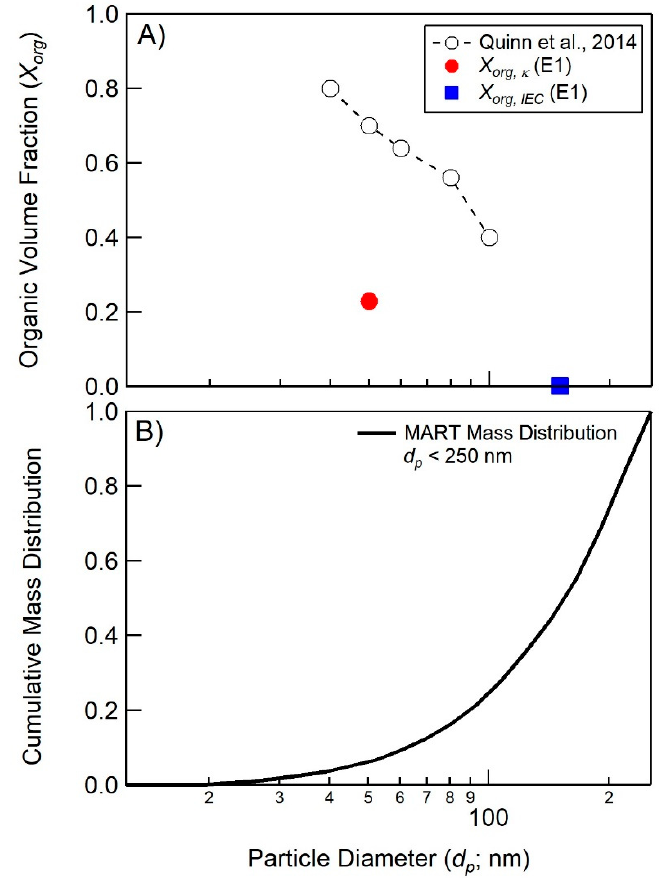
Figure 4. ( A ) Determinations of aerosol organic volume fraction X org measurements as a function of dry particle diameter for experiment 1 derived from hygroscopicity (red circle) and IEC measurements (blue square positioned at 50% size cut point). Also shown, are calculations of X org derived from hygroscopicity measurements made on SSA generated from seawater in the Atlantic Ocean by Quinn et al. [10]. ( B ) Cumulative dry aerosol mass distribution for representative, laboratory-generated SSA from Prather et al. [78].